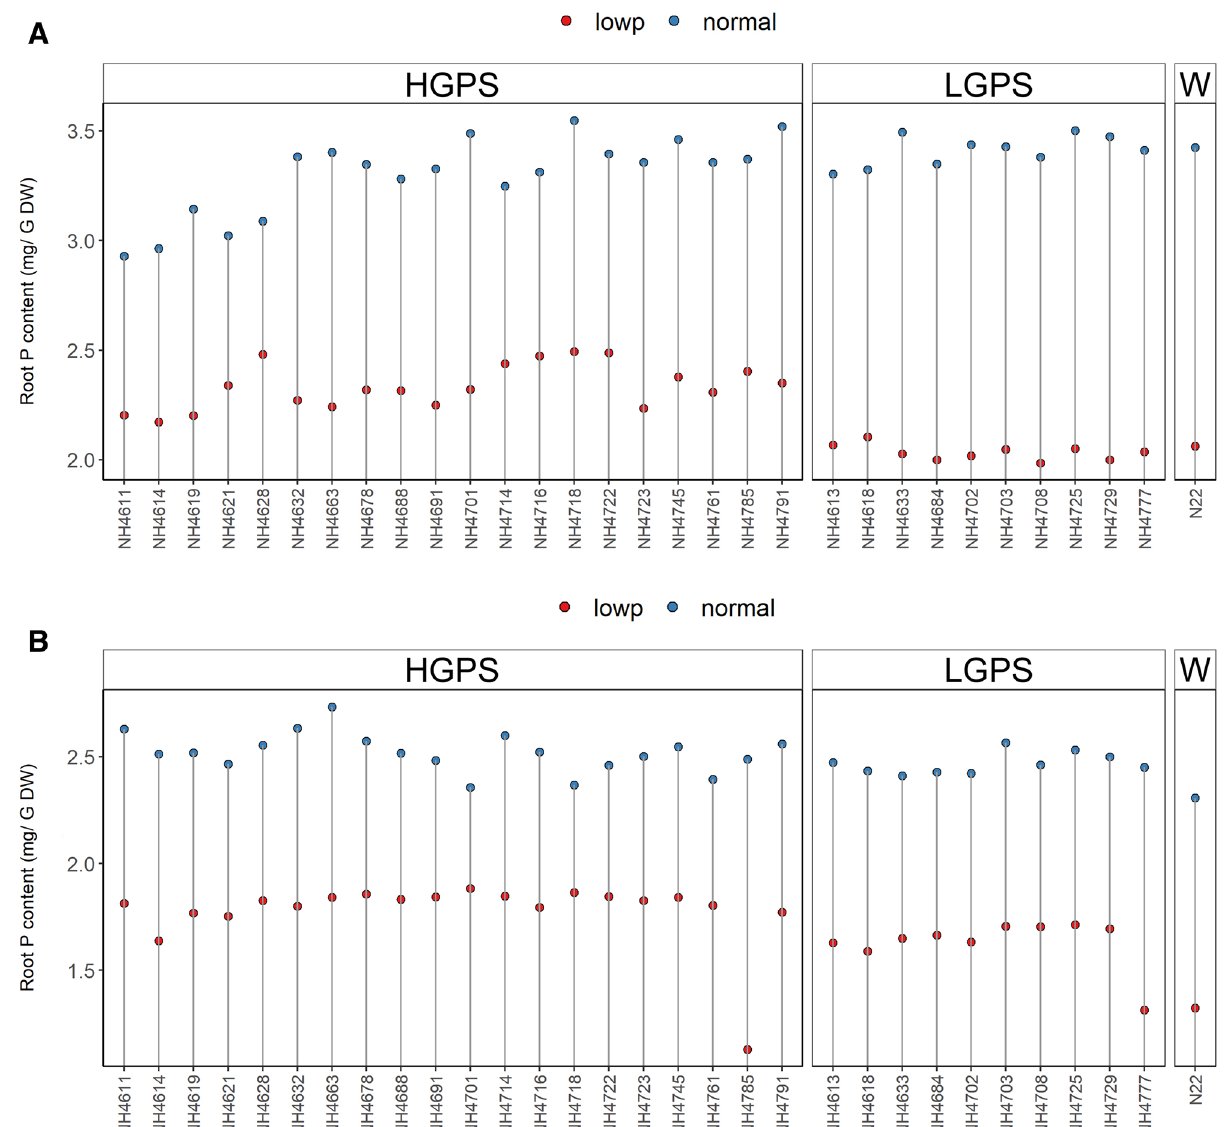
Figure 10. Root P content of seedlings obtained from germination of seeds harvested from low P (shown as red dots) and normal P (shown as blue dots) fields. Wild type N22 (W), high grain P mutant seedlings (HGPS), and low grain P mutant seedlings (LGPS) were grown under normal P condition. ( A ) Root P content at 12 days of germination. ( B ) Root P content at 24 days of germination. The values represent the mean of 6